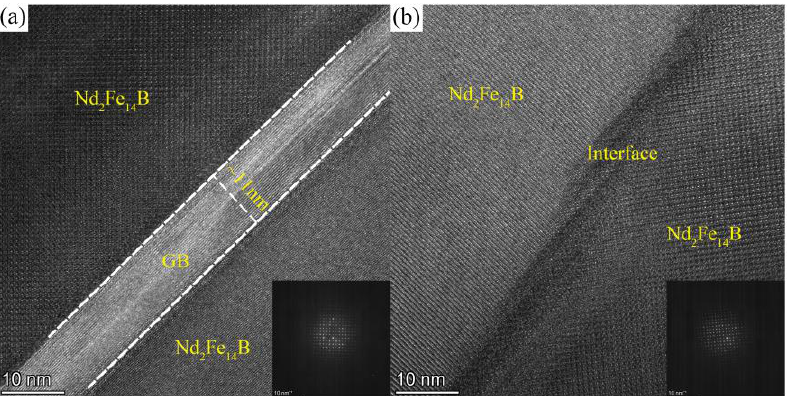
Figure 6. TEM images of the grain boundary structure: ( a ) Tb60 diffusion magnet and ( b ) Tb diffusion magnet.